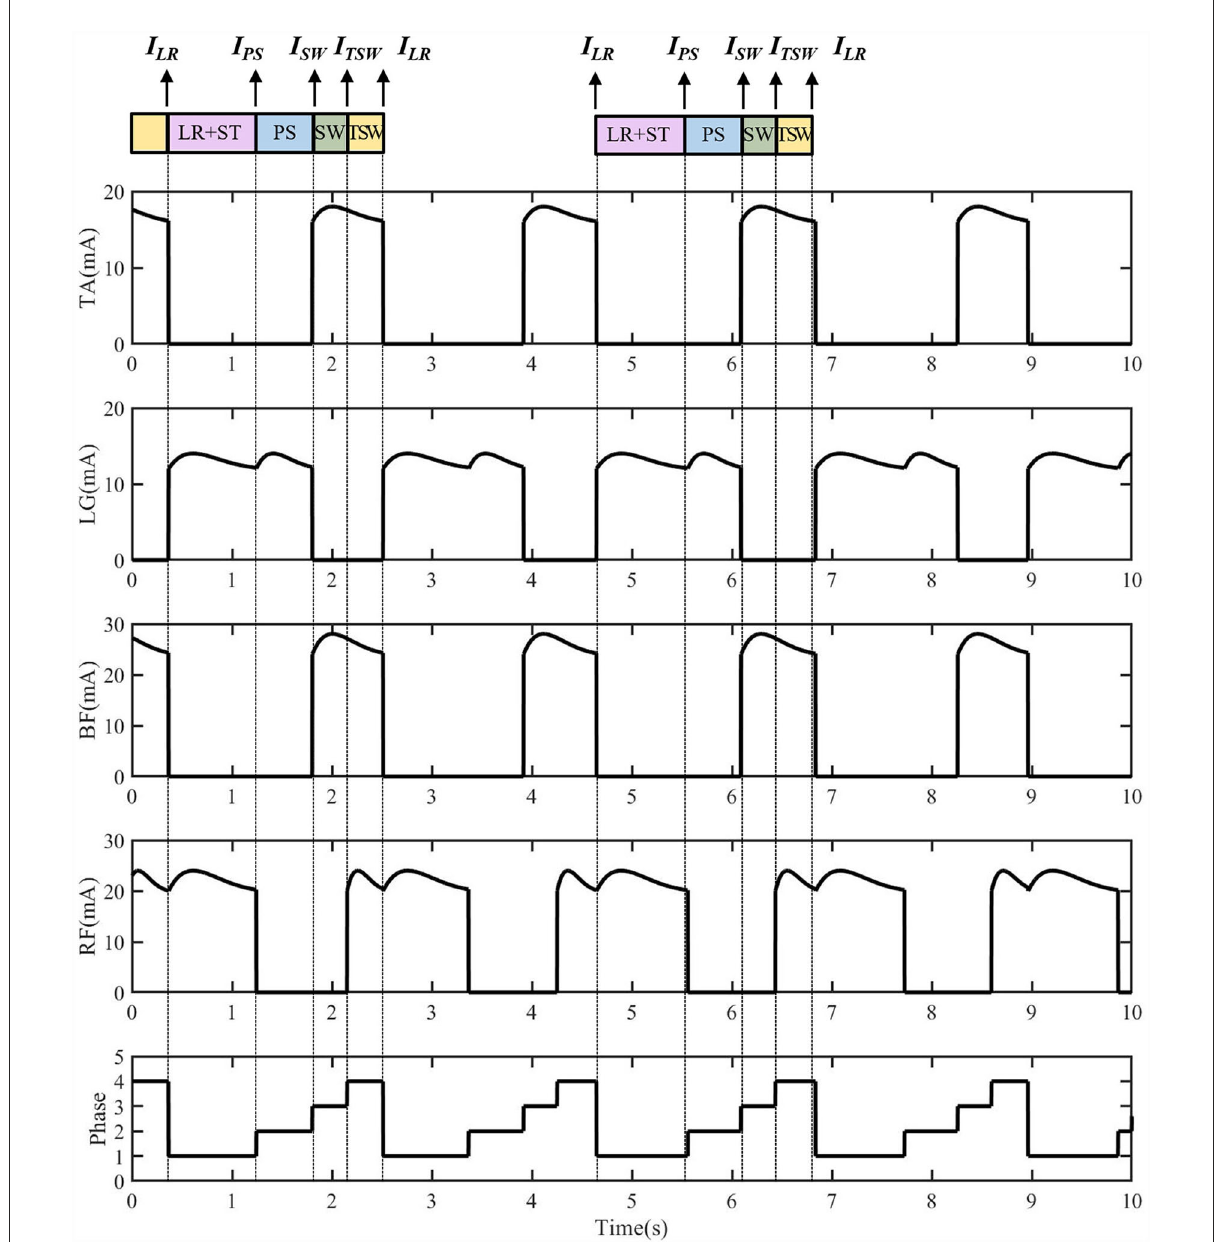
FIGURE3 The electrical stimulation sequences for four muscles of one side generated from the reflexive FES controller. The I LR triggered the lateral gastrocnemius (LG) and rectus femoris (RF) muscle activations for the knee extension and hip flexion. The I PS triggered the LG muscle for ankle plantarflexion. The I SW triggered the tibialis anterior (TA) and biceps femoris (BF) muscles for the ankle dorsiflexion, knee flexion, and hip extension at early swing. The I TSW triggers TA, RF, and BF muscles for the preparation of load